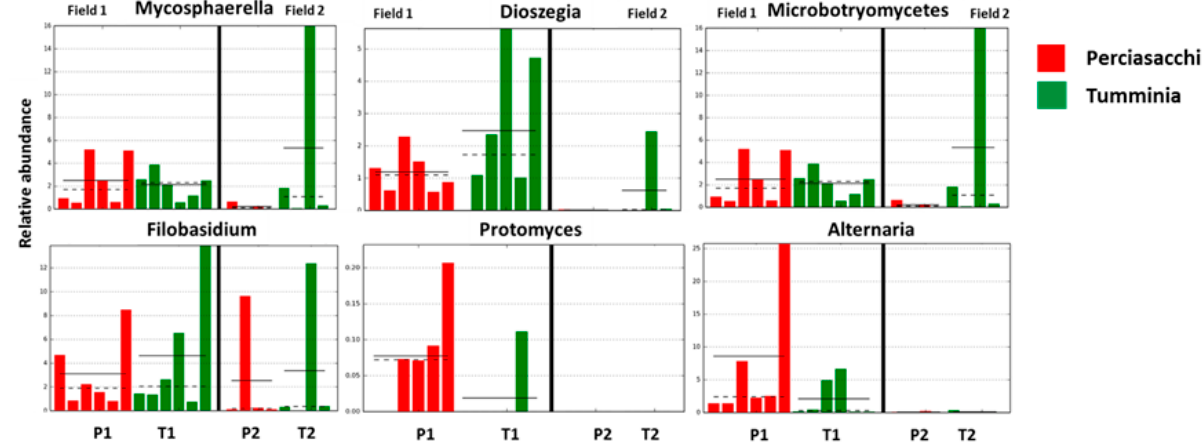
Figure 5. Differentially abundant genera between two ancient wheat varieties and two fields. Histograms indicate significant differences cal- culated by LEfSe analyses ( P a< 0.05 and LDA cut-off >2). P1 = Perciasacchi from Field 1; T1 = Tumminia from Field 1; P2 = Perciasacchi from Field 2; and T2 = Tumminia from Field 2. Category means (straight line) and medians (dotted line) are